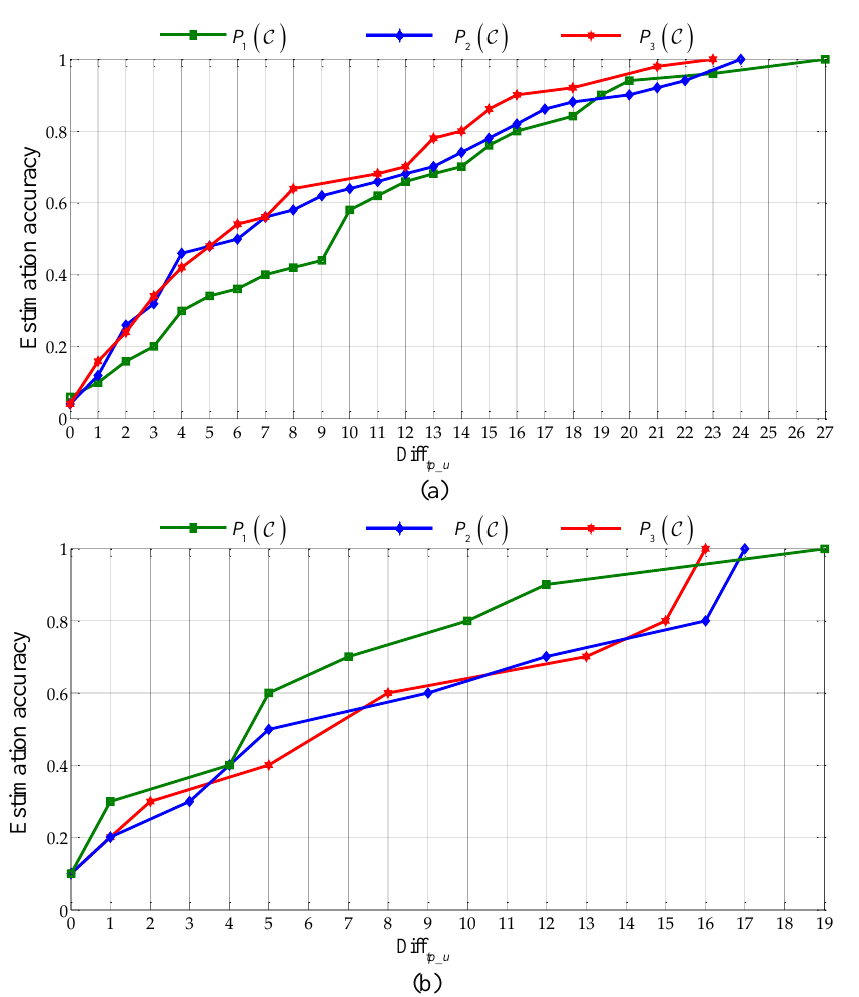
Figure 12. Estimation accuracy of the three fitted curves. ( a ) Estimation accuracy based on data sets 1–5. ( b ) Estimation accuracy based on data set 5.